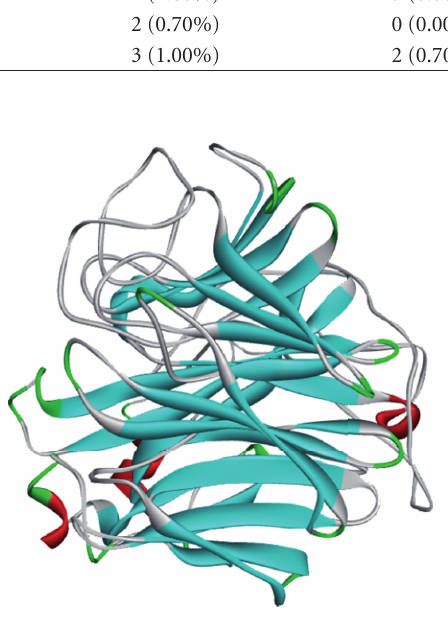
Figure 1: 3D representation of NA best model.